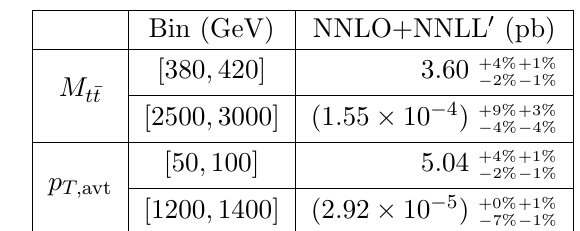
Table 2 . Cross section in \high" and \low" energy bins. The (cid:12)rst uncertainties refer to those from (cid:22) f variation only while the second set are generated by the variation of the matching scales.